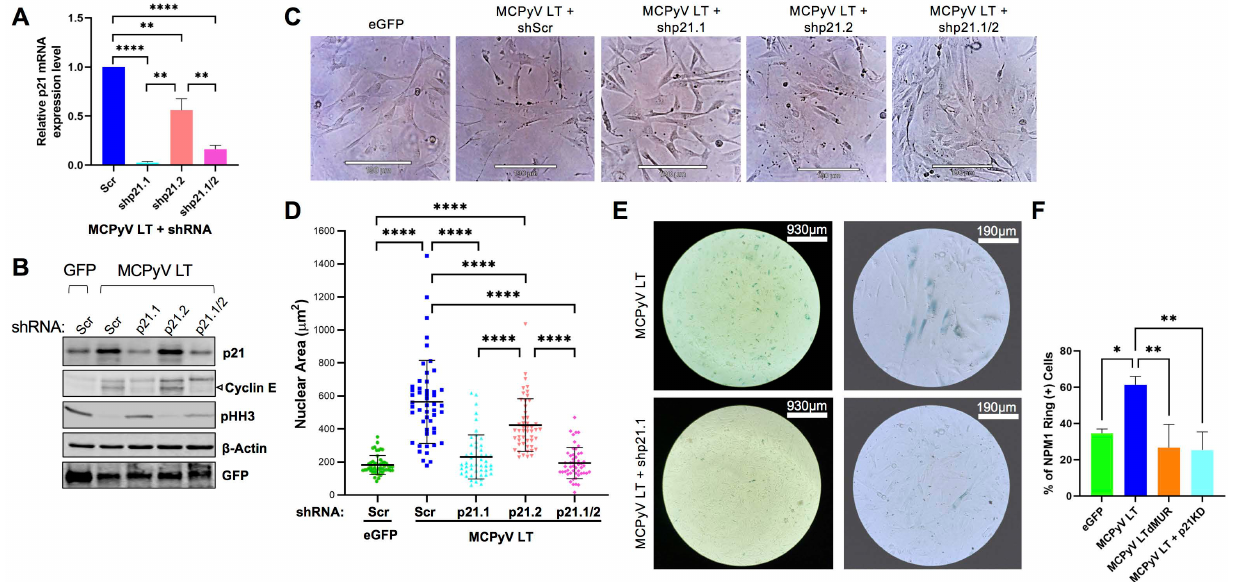
Figure 3. MCPyV LT induces p21 − dependent cellular senescence. ( A ) p21 mRNA levels